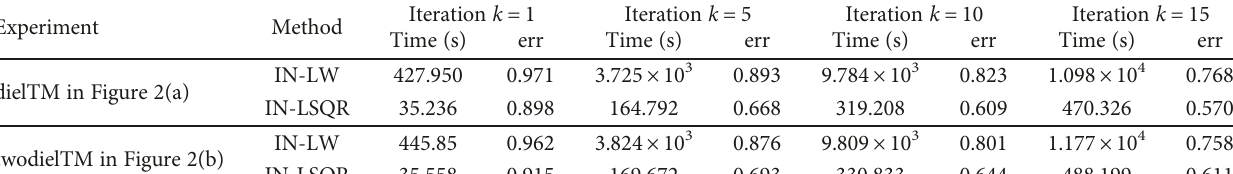
Table 2: Comparison of IN-LW and IN-LSQR methods in terms of computation time and contrast error at k = 1, 5, 10, 15 . Experiment dielTM in Figure 2(a)